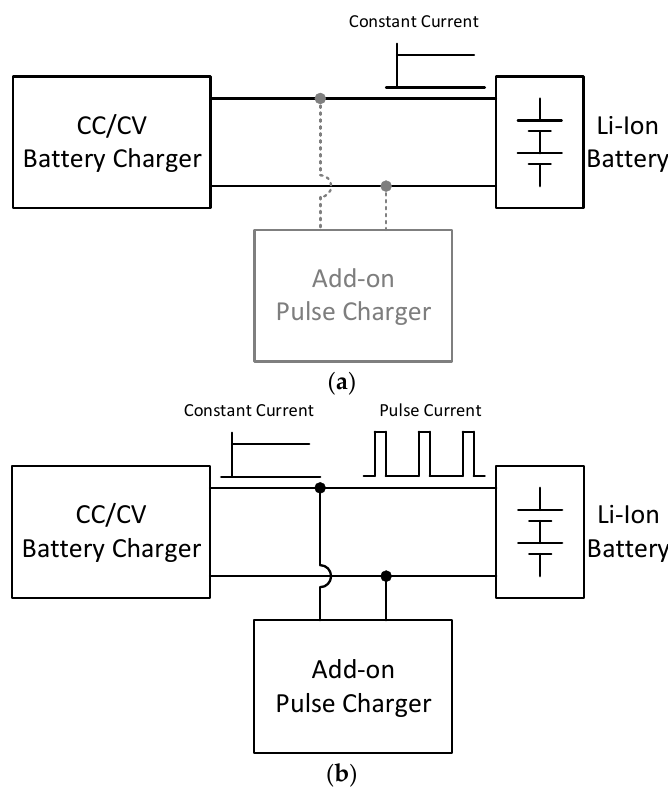
Figure 2. Structure of the conventional charging system. ( a ) Pulse charger ( b ) CC–CV charger.